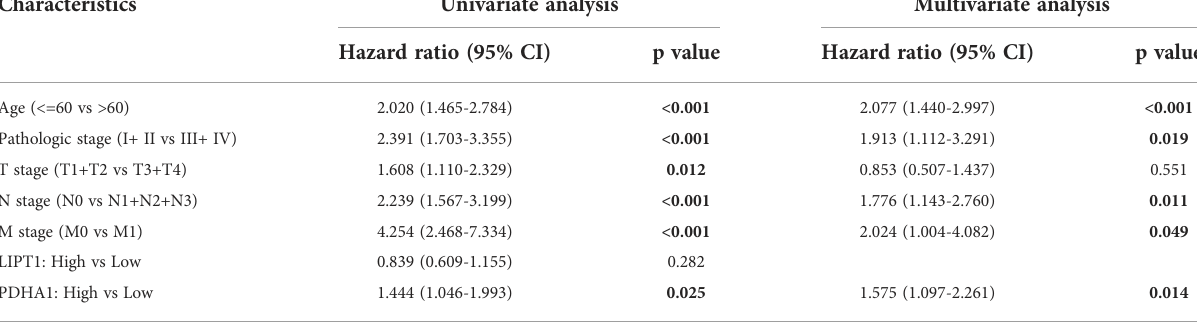
TABLE 1 Univariate and multivariate Cox analyses of prognostic factors in breast cancer.